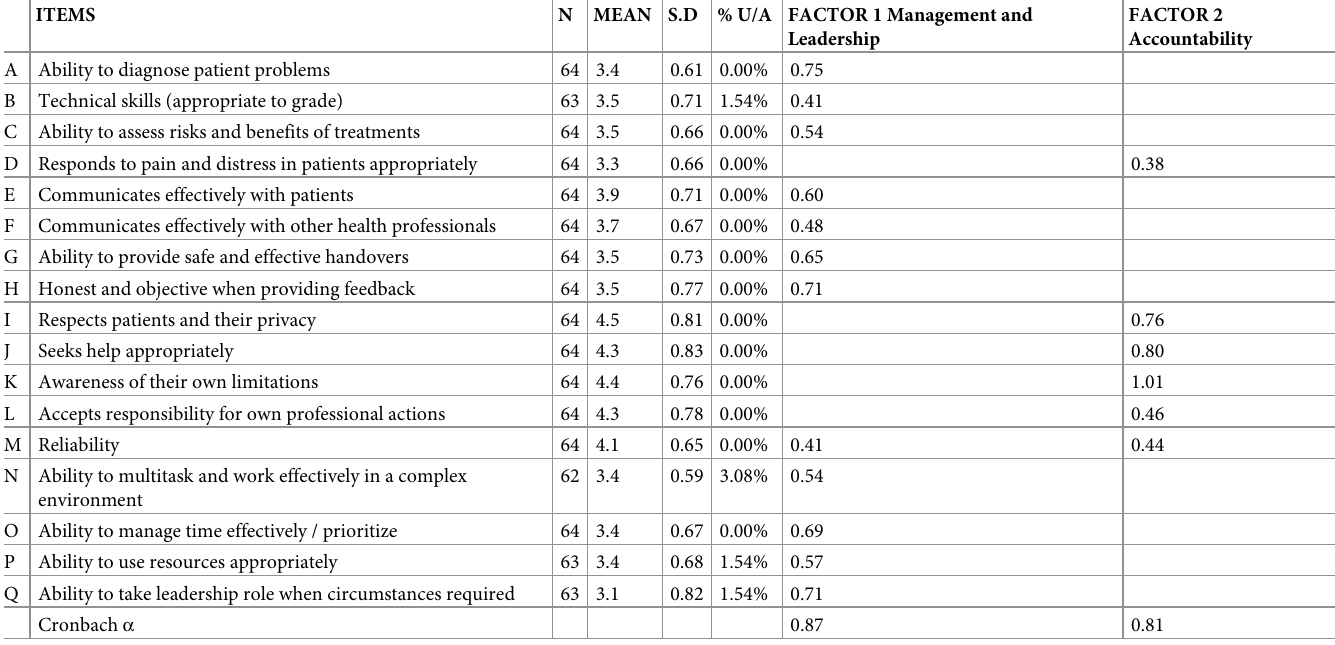
Table 3. Details about questions, response rate, and unable to assess rate, factor analysis and Cronbach α scores for self-questionnaire.